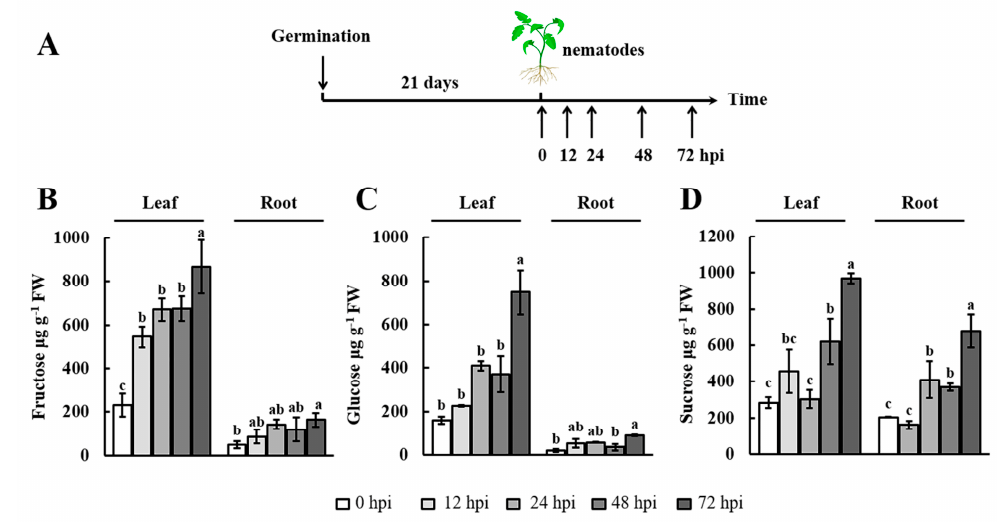
Figure 1. Soluble sugar content in the leaves and roots after nematode infection. ( A ) Scheme of leaf and root sampling for soluble sugar measurements; ( B – D ) The soluble sugar content was monitored by high-performance liquid chromatography with refractive index detection (HPLC–RID) in leaves and roots at 0, 12, 24, 48, and 72 h postinoculation (hpi) with Meloidogyne incognita . The experiments were repeated three times. Data represent the means ± SE ( n = 3). Significant differences ( p < 0.05) between the groups are indicated by different letters. SE, standard error. FW, fresh weight.